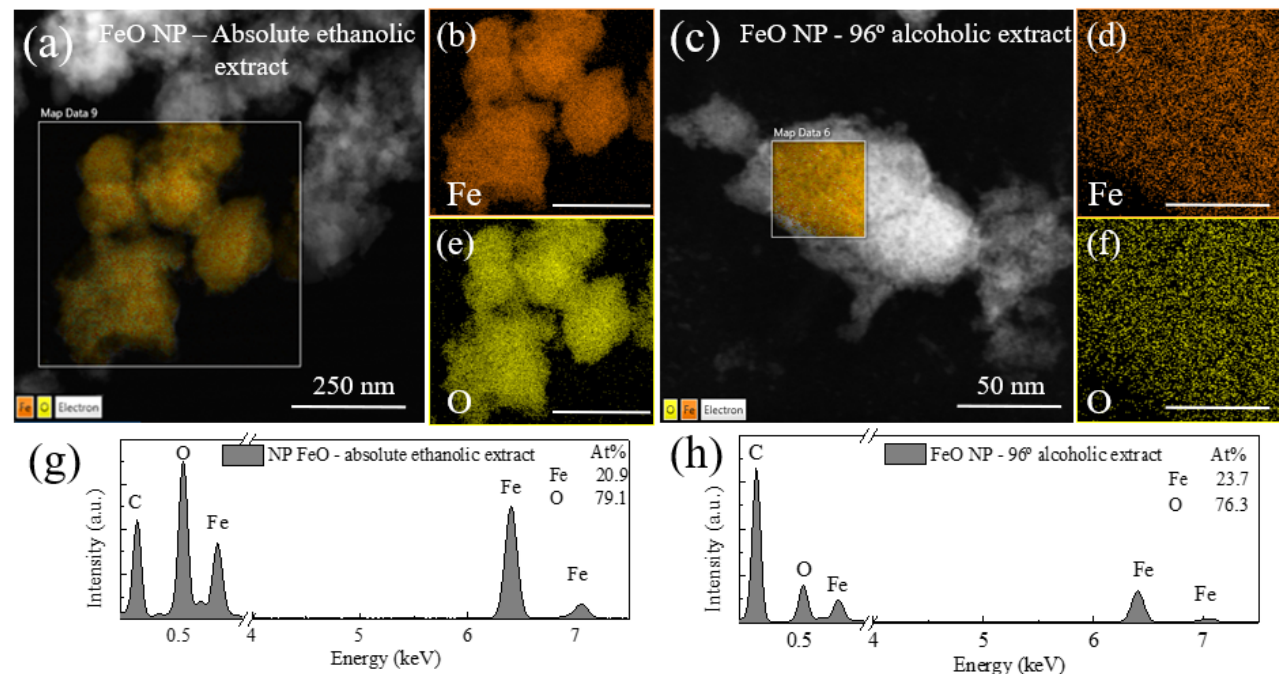
Figure 6. EDS spectrum of iron oxide nanoparticles synthesized using M. indica extract ( a,b,e,g ) absolute ethanolic solvent, ( c,d,f,h ) 96% alcoholic solvent.